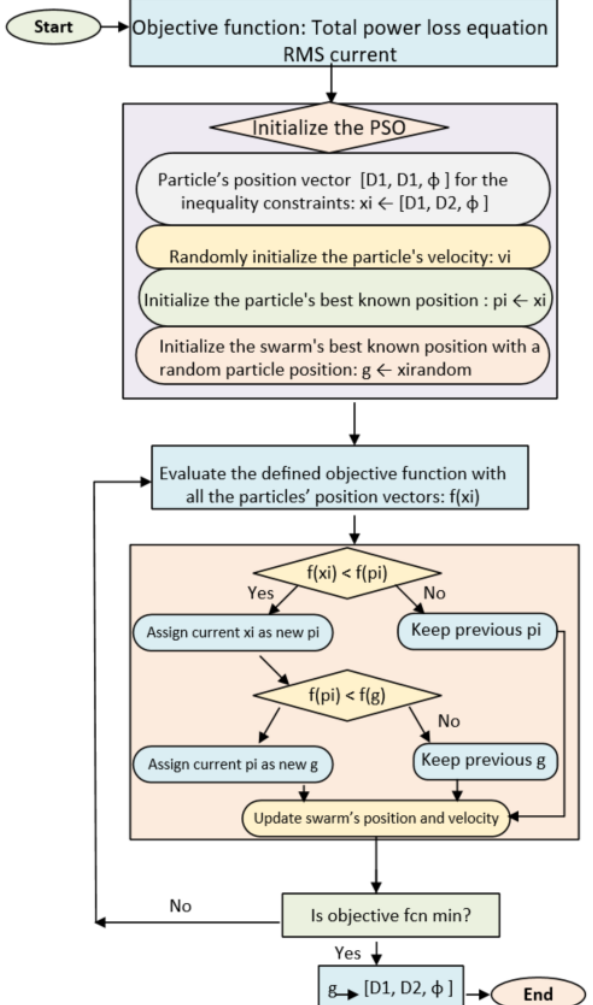
Figure 10. PSO flow